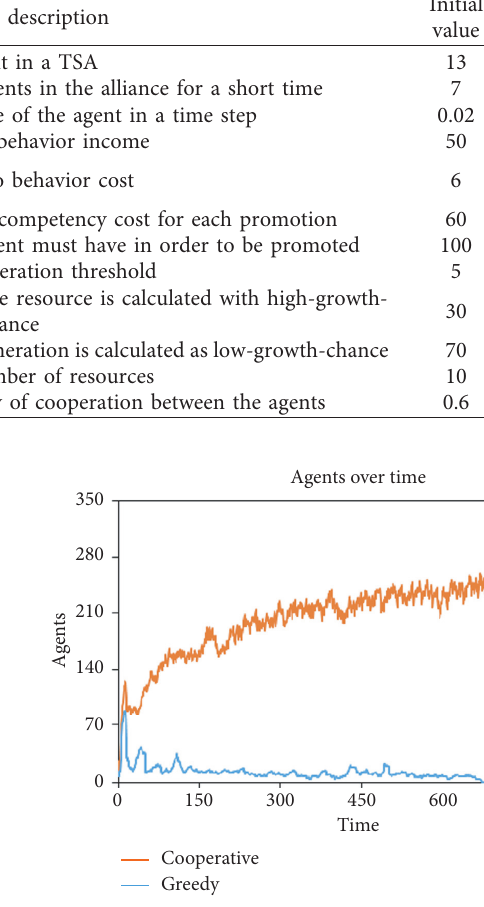
Figure 7: Later simulation